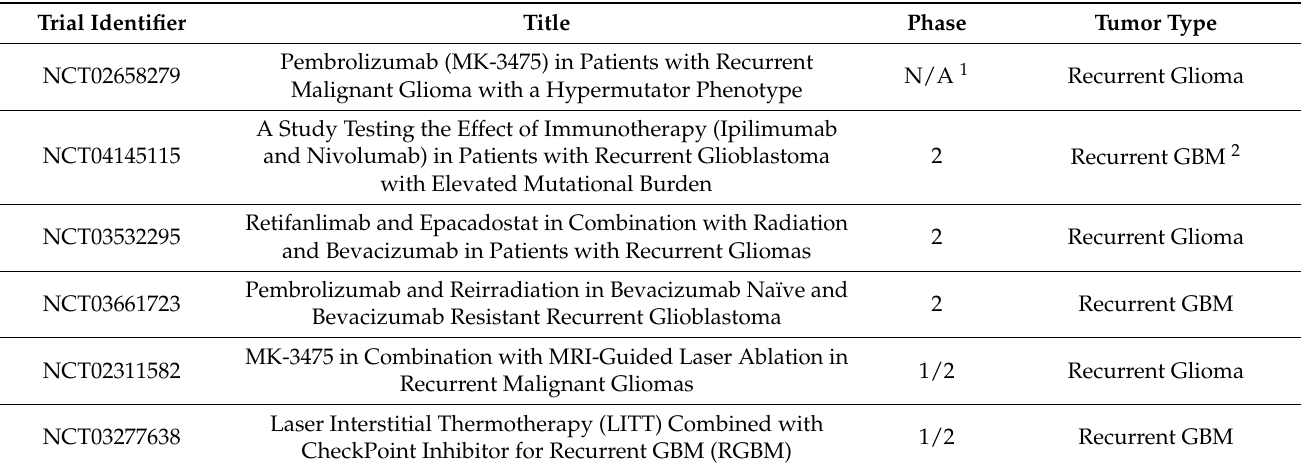
Table 1. Ongoing Checkpoint Inhibitor Clinical Trials in